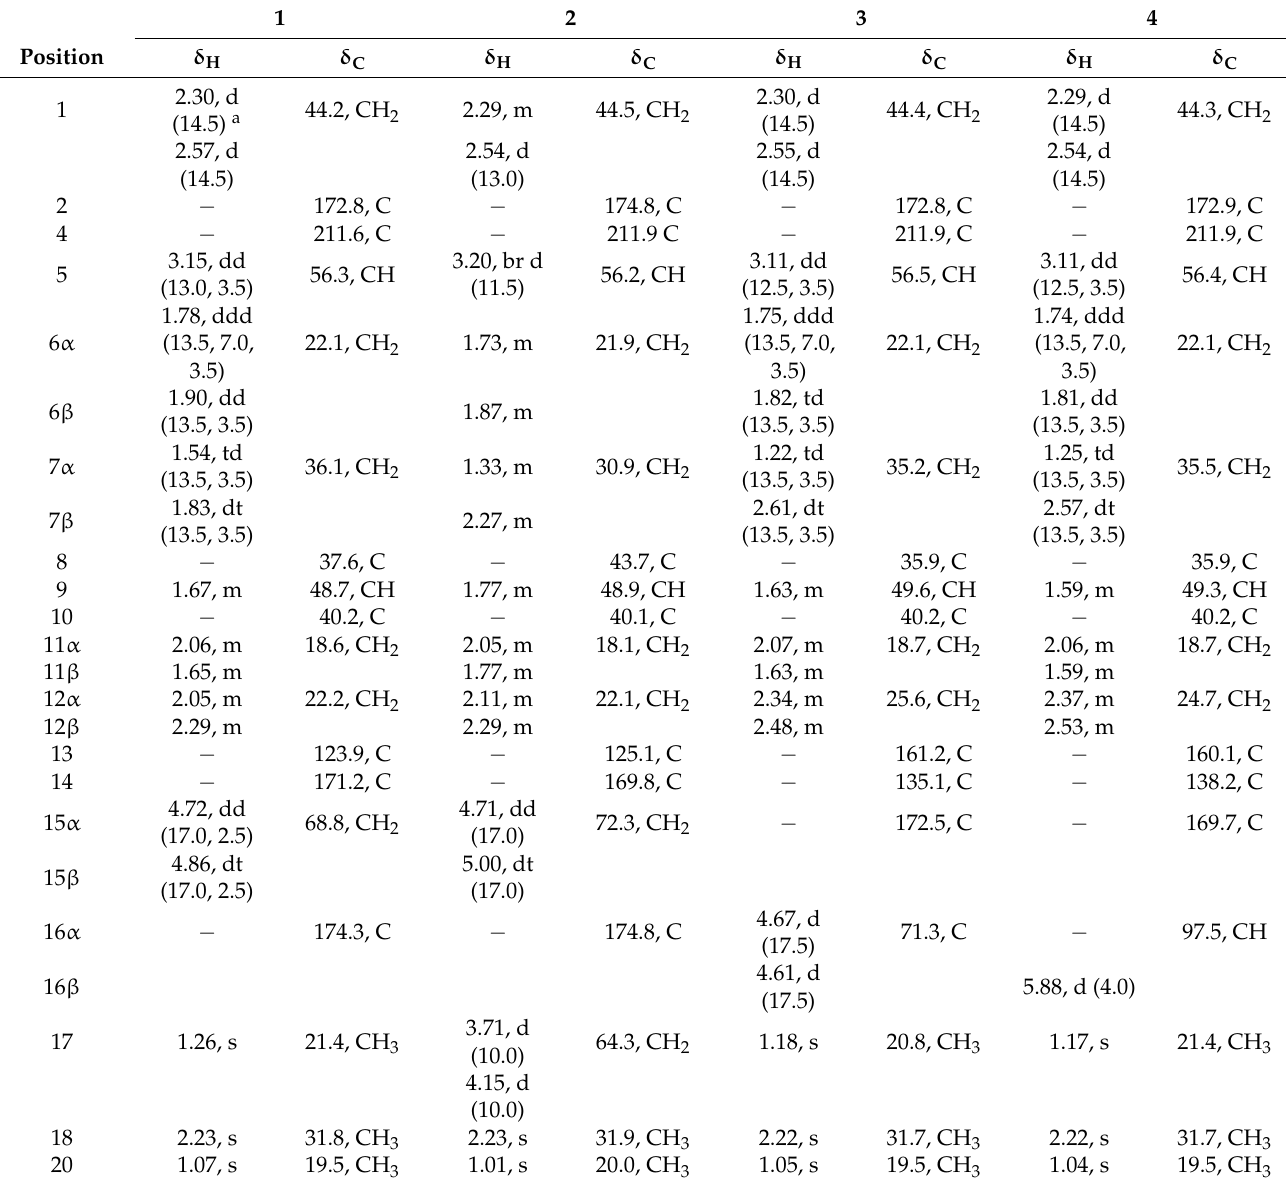
Table 1. 13 C and 1 H NMR data for compounds 1 – 4 (125/500 MHz) in acetone- d 6